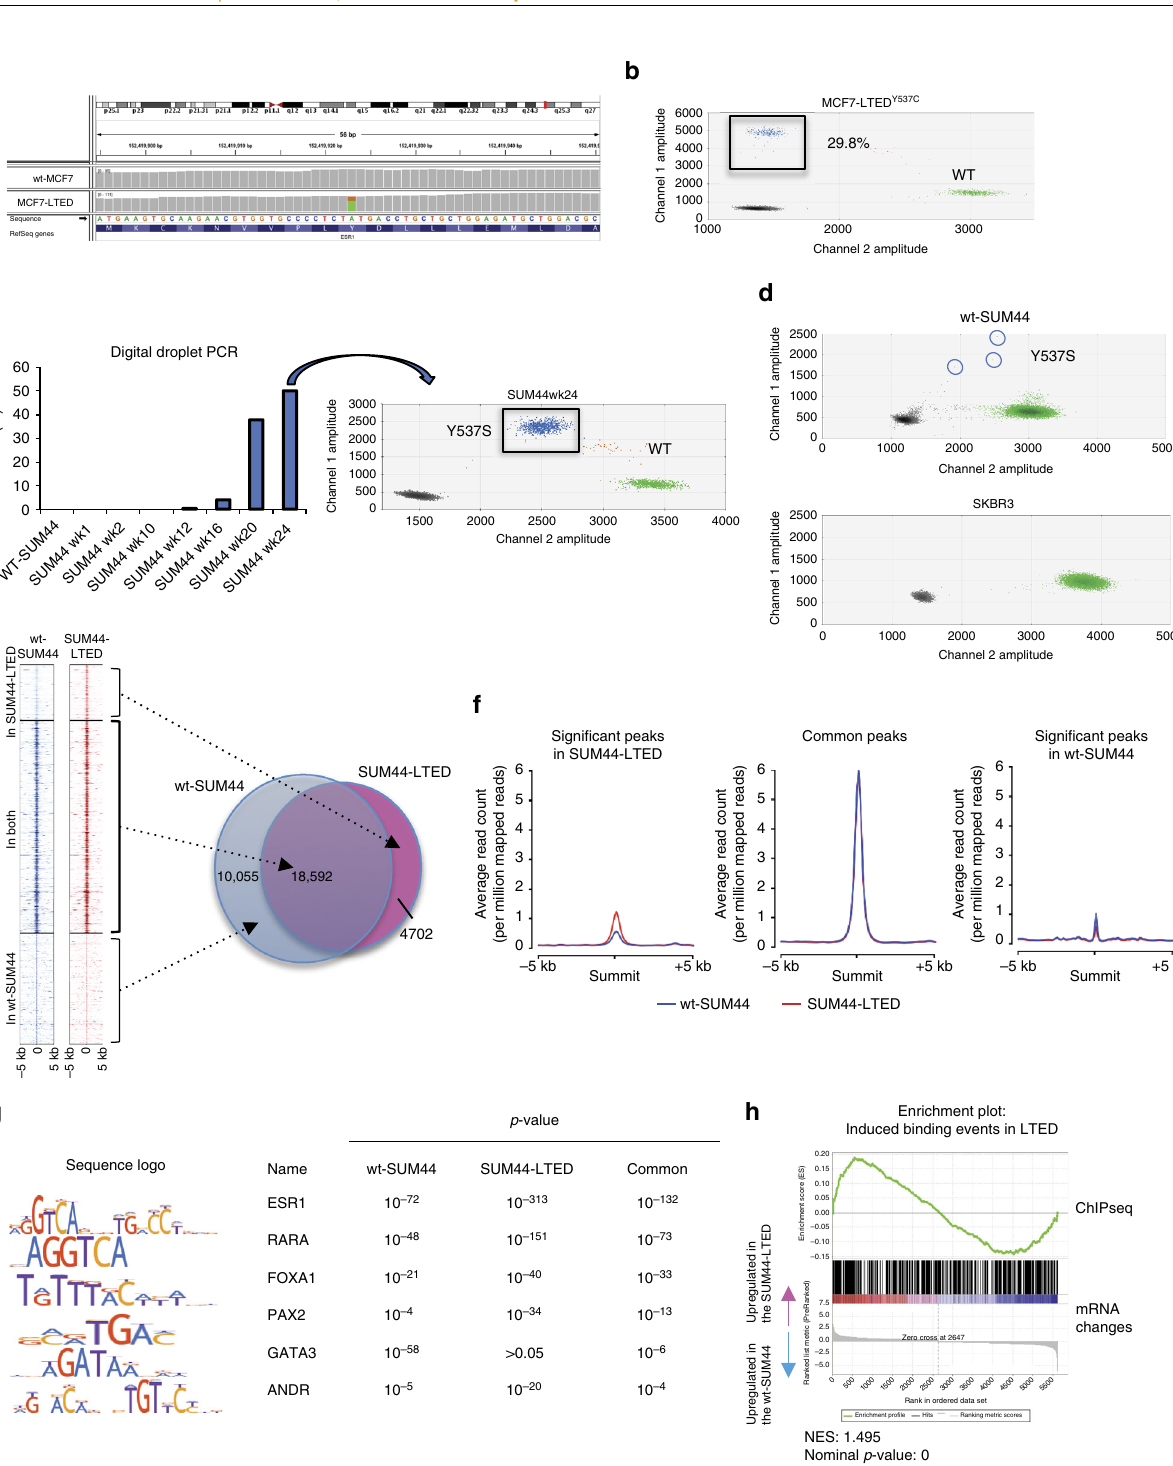
Fig. 1 Identi fi cation and characterization of ESR1 mutations in models of endocrine resistance. a Visualization of ESR1 Y537C identi fi ed during exome sequencing. b Digital droplet PCR (ddPCR) showing the presence of the ESR1 Y537C mutation in MCF7-LTED. c ddPCR showing the presence of the ESR1 Y537S mutation in SUM44-LTED. Temporal analysis showing enrichment of the mutation from wk12 post-estrogen deprivation. d ddPCR showing the presence of ESR1 Y537S at low variant allele frequency (VAF) in wt-SUM44 but not in SKBR3. e Overlap between wt-SUM44 and SUM44-LTED ESR1 binding sites and corresponding heatmap. The heatmap depicts binding peak intensities, which are common or different between the two cell lines. The window represents